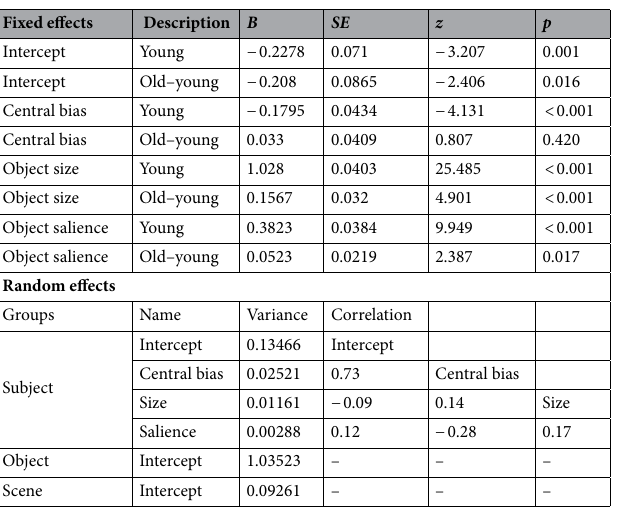
Table 2. Object GLMM. Age-related effects on fixation probability during scene viewing are modelled relative to annotated objects in scenes. Standardized coefficients ( b ), standard errors ( SE ), z - and p -values for fixed effects and variances and correlations for random effects are